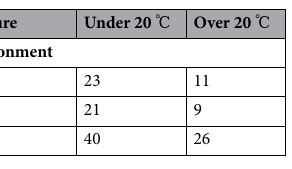
Table 2. The case number classified to water temperature and drowning